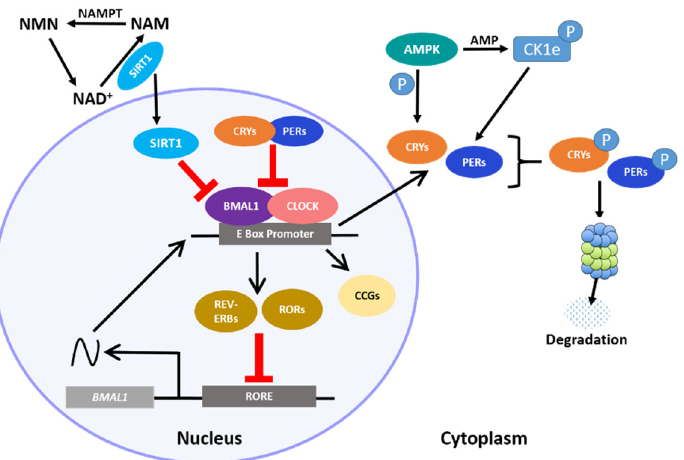
Figure 1. Interactions between the core clock and intracellular metabolism. The heterodimerization of BMAL1 and CLOCK proteins and subsequent binding to E-Box-containing regulatory elements leads to expression of the repressor PER and CRY proteins, the REV-ERBs and RORs, which initiate the auxiliary loop, and the core clock genes (CCGs) that drive numerous other intracellular rhythms. Cytoplasmic PER and CRY proteins are eventually tagged for degradation by AMPK. Rhythmic cellular metabolism, such as rhythmic NAD + abundance, participates in the core clock by direct regulation of clock-associated factors, such as the anti-aging-associated histone deacetylase protein, SIRT1.